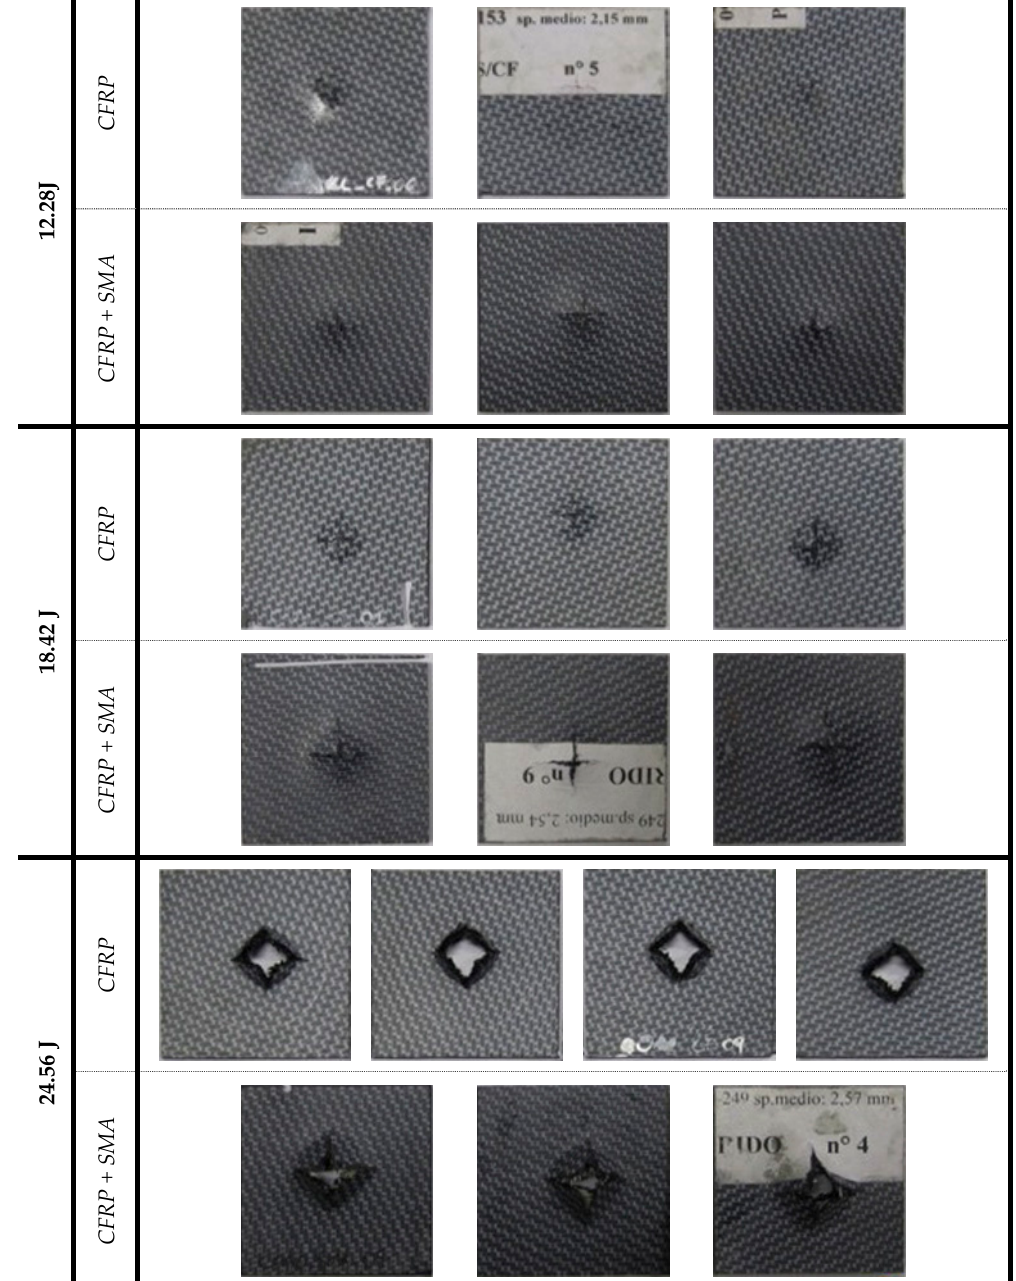
Figure 3. Inspection of the impacted samples.